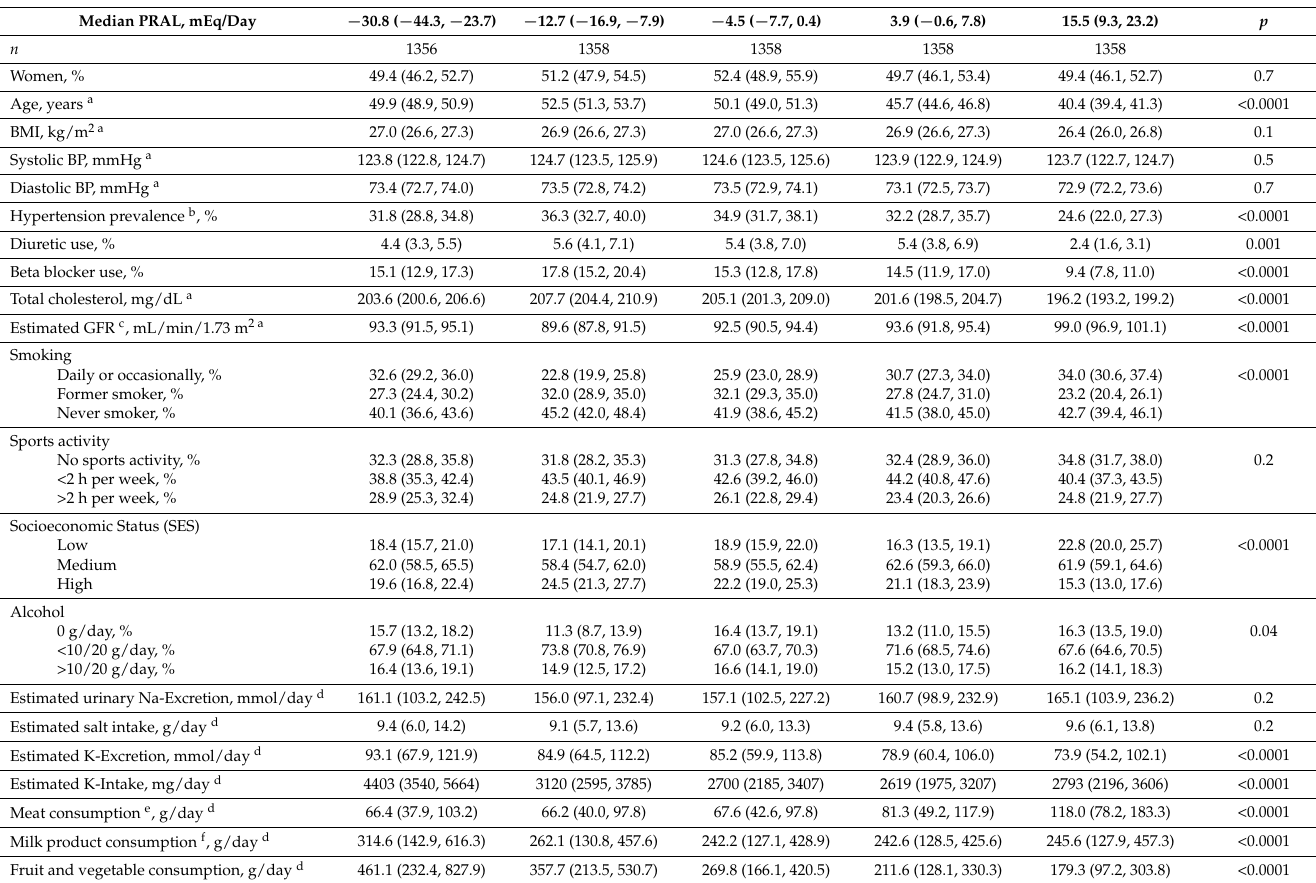
Table 1. Characteristics of the German Health-Interview and Examination Survey for Adults (DEGS1) study population in sex-balanced quintiles of dietary potential renal acid load (PRAL) ( n =